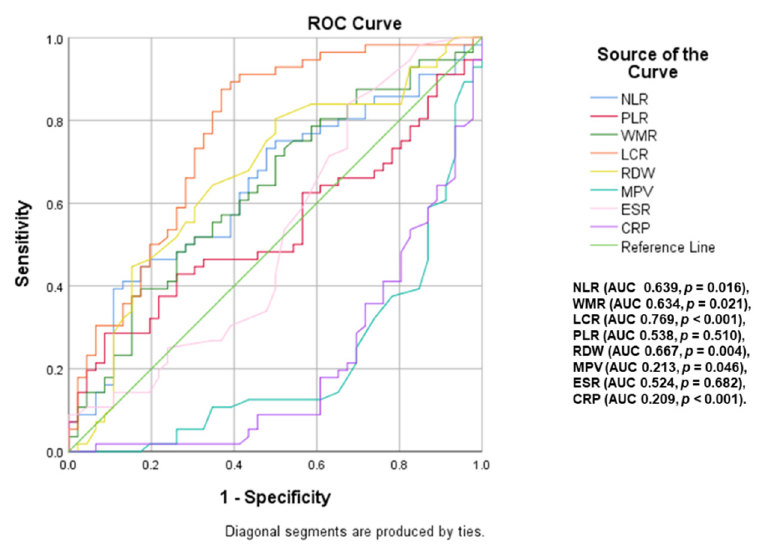
Figure 3. Impact of inflammatory parameters in predicting moderate–severe OSA (NLR: neutrophil-lymphocyte ratio; WMR: white blood cell count-to-mean platelet volume ratio; LCR: lymphocyte-to-CRP ratio; ESR: erythrocyte sedimentation rate; CRP: C-reactive protein; PLR: platelet-to-lymphocyte ratio; RDW: red cell distribution width; MPV: mean platelet volume).